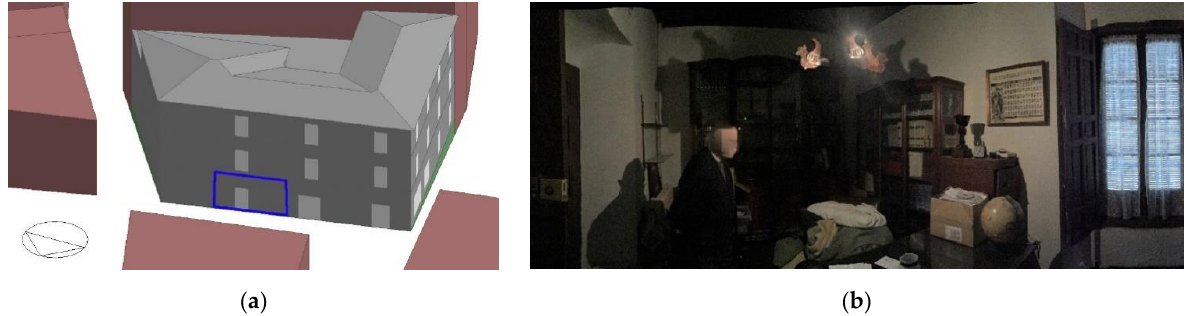
Figure 1. Studied building in Campo de Criptana (Ciudad Real, Spain): ( a ) North-facing façade in DesignBuilder, indicating the location of the monitored room ( b ) Panoramic view of the room.